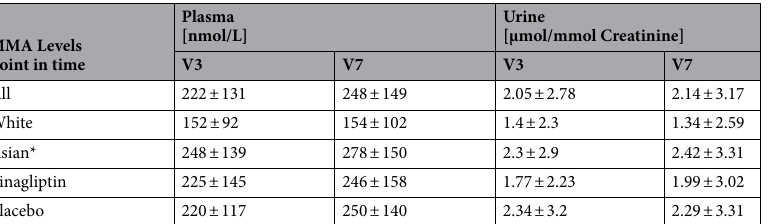
Table 3. Patient characteristics and pMMA and uMMA values of a subset of individuals from the MARLINA trial. Arithmetic means and standard deviations of MMA values in plasma and urine per point in time and group. MMA methylmalonic acid; V3 baseline; V7 end of study. *Significantly higher plasma and urine MMA levels in Asian patients compared with White patients (Welch -test).